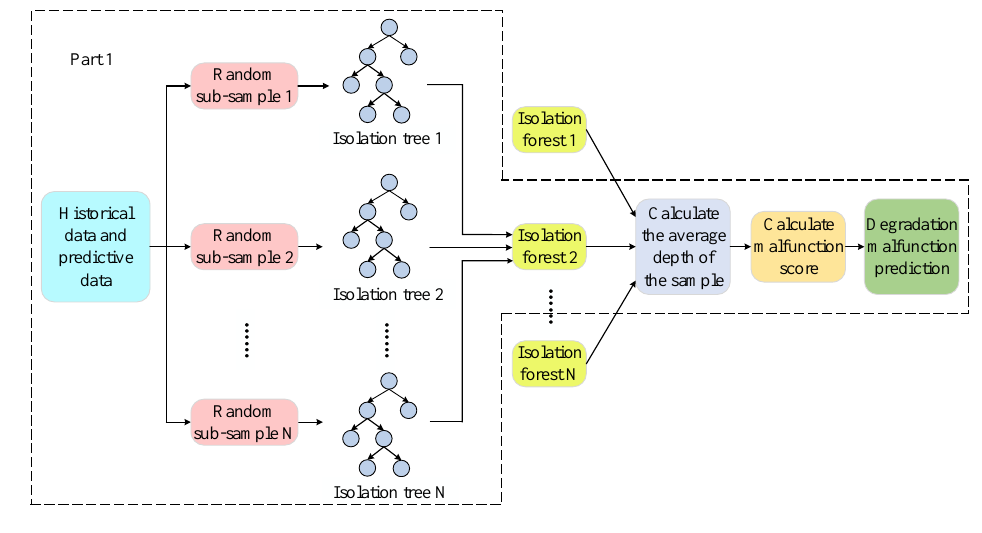
Figure 2. M-iForest flow chart.